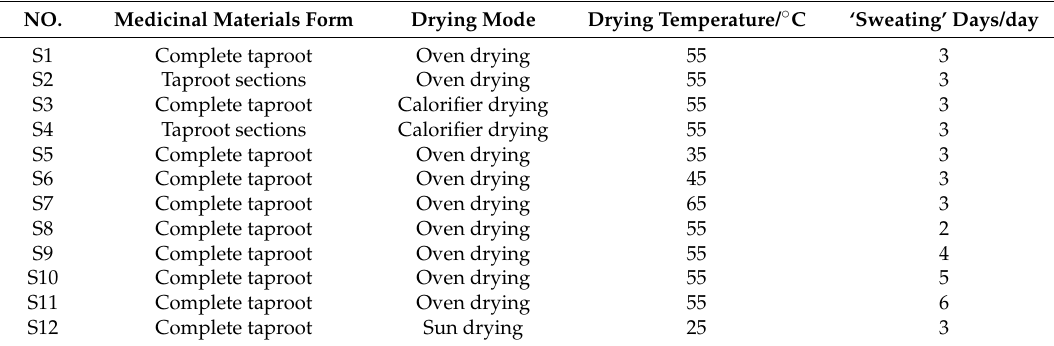
Table 7. Summary of the tested samples of Scrophulariae